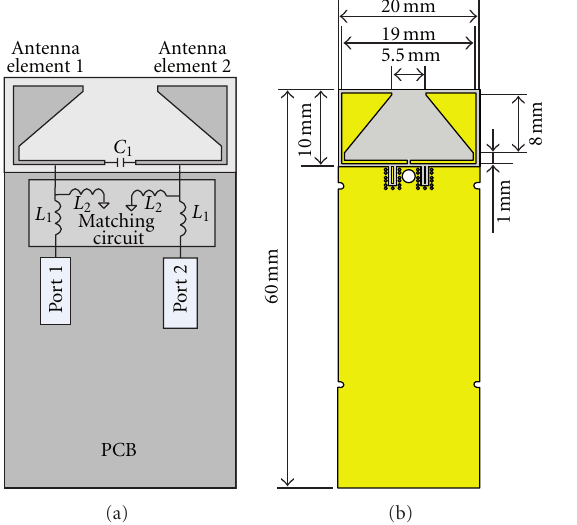
Figure 9: Structure (a) and CST Microwave Studio model (b) of the designed compact two-element MIMO antenna system #2.